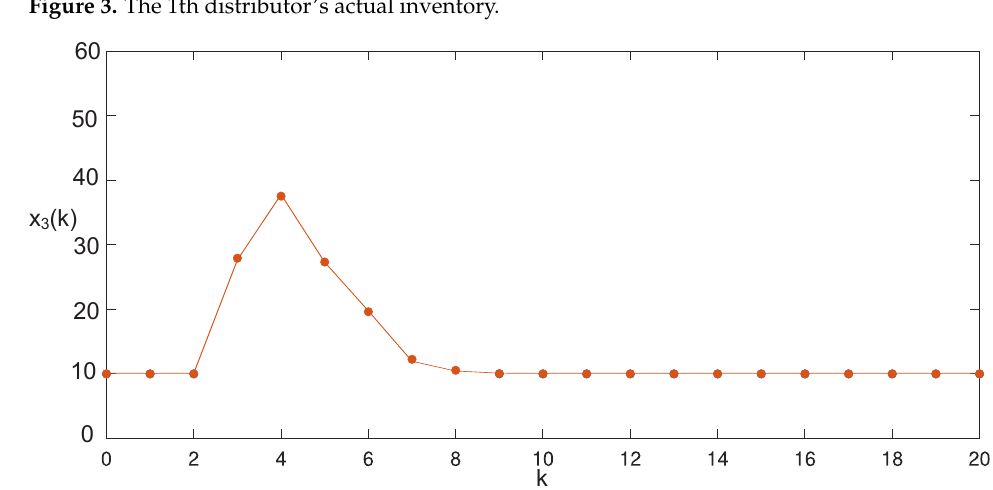
Fig. 8. Response of the designed closed-loop output-feedback control system ( r = 1 and q = 5 ).